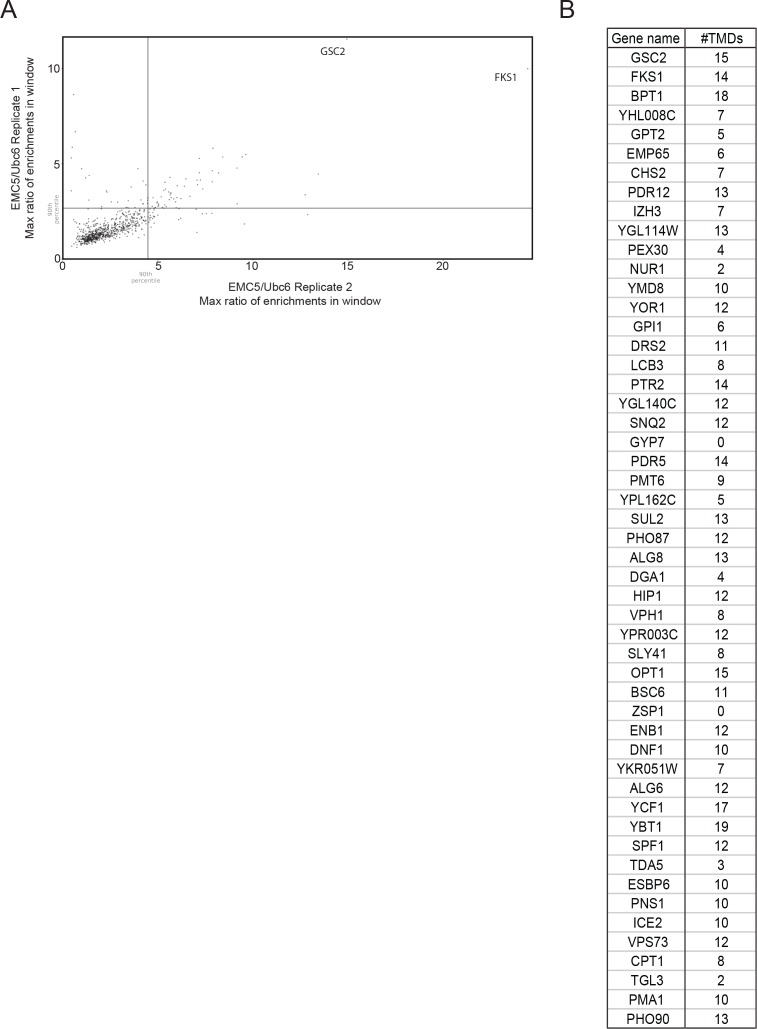
Maximum 101-codon EMC/Ubc6 enrichment ratio windows from two independent Emc5-BirA replicates.(A) Scatterplot of maximum 101-codon enrichment windows for each gene represented in two independent replicates of Emc5-BirA ribosome profiling. (B) List of genes above the 90th percentile in both replicates.